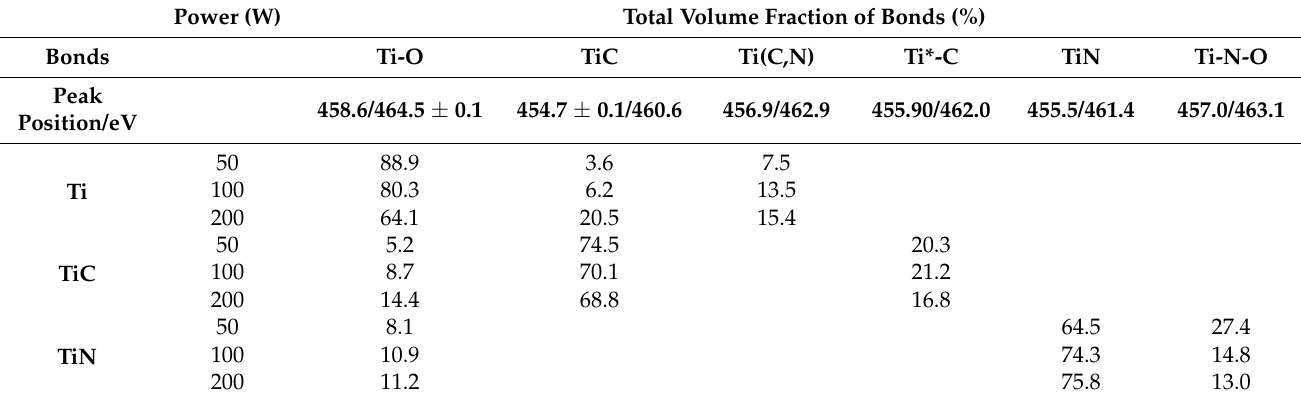
Table 2. XPS analysis results of Ti 2 p.